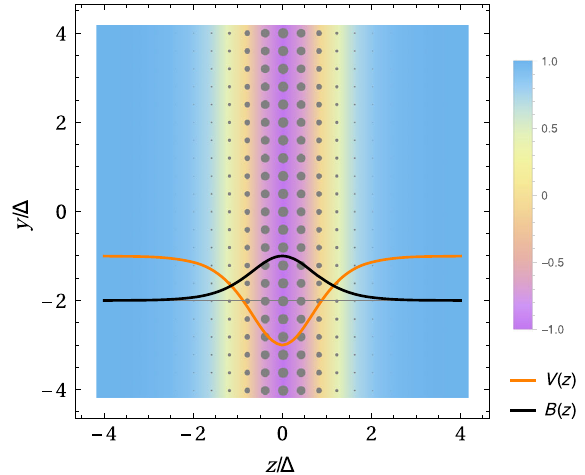
FIG. 3. The spatial profile for the effective scalar potential and the effective magnetic field. We show the spatial distribution of the scalar potential V ð z Þ and the magnetic field B ð z Þ in the y - z plane. The density map is the scalar potential, and the disk size represents the magnitude of the magnetic field pointing in the x